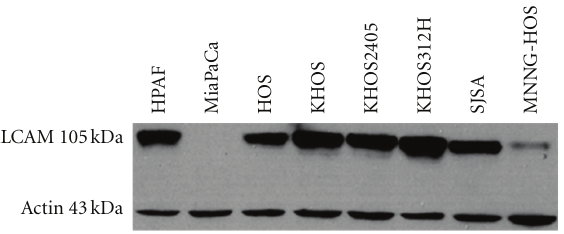
Figure 1: ALCAM/CD166 is highly expressed in osteosarcoma cell lines. Western immunoblot analysis of osteosarcoma cell lines prob- ed with α -ALCAM antisera. There is high total cell expression of ALCAM in HOS, KHOS, KHOS240s, and SJSA with moderate expression in the MNNG-HOS cell line. A pancreatic cancer cell line, HPAF, with known high levels of ALCAM expression was used as a positive control. MiaPaCa, a pancreatic cancer cell line with known lack of ALCAM expression served as a negative control. Membrane-localized ALCAM isoform is present at 105 kDa. β - Actin was used as an internal loading control.